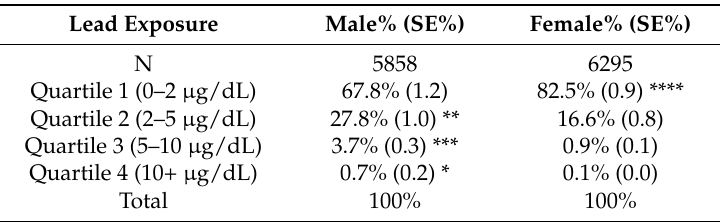
Table 1. Gender and quartiles of exposure.